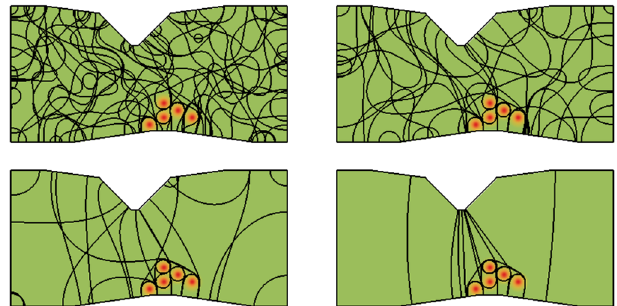
FIG. 10. Evolution of isoglosses in a 400 × 200 system with two opposing boundary indentations and unit background population density, together with a collection of cities contributing additional population densities ρ ð r Þ ¼ ð ρ 1 − 1 Þ exp f − r 2 = ð 2 R 2 Þg , where r is distance from city center, R ¼ 10 , and ρ 1 ¼ 4 (measuring ratio of peak city density to background). Parameter values σ ¼ 4 , β ¼ 2 . Evolution times t ¼ 10 , 50, 300, 1660. See video in Supplemental Material for full animation